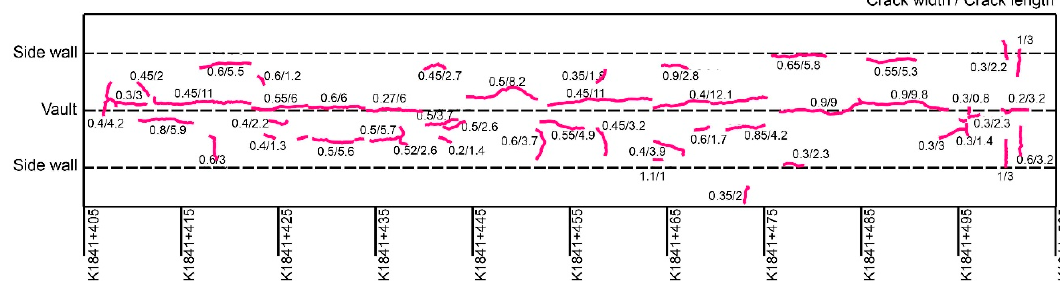
Figure 9. Planar unfolding view of lining cracks.